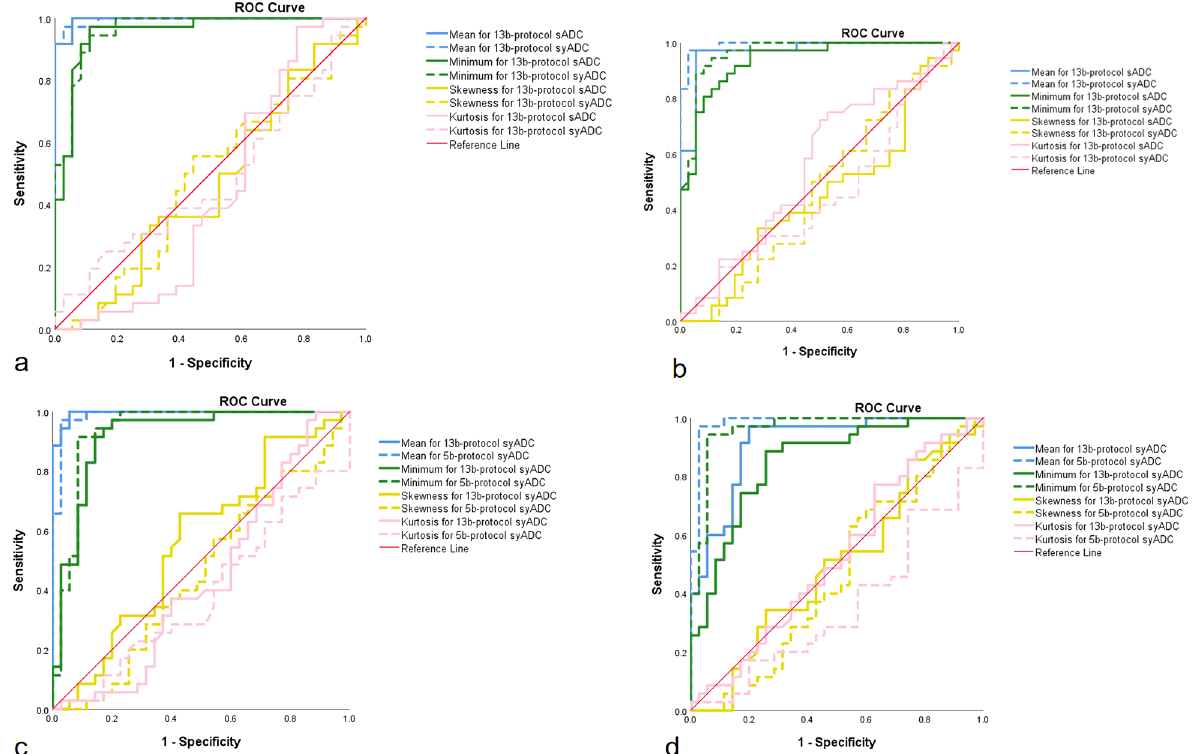
Fig. 4 Diagnosis efficiency of scanned and synthetic 13b-protocol ADC values with a b value of 0 and 1200 ( a ) or 1500 ( b ) s/mm 2 as well as that of